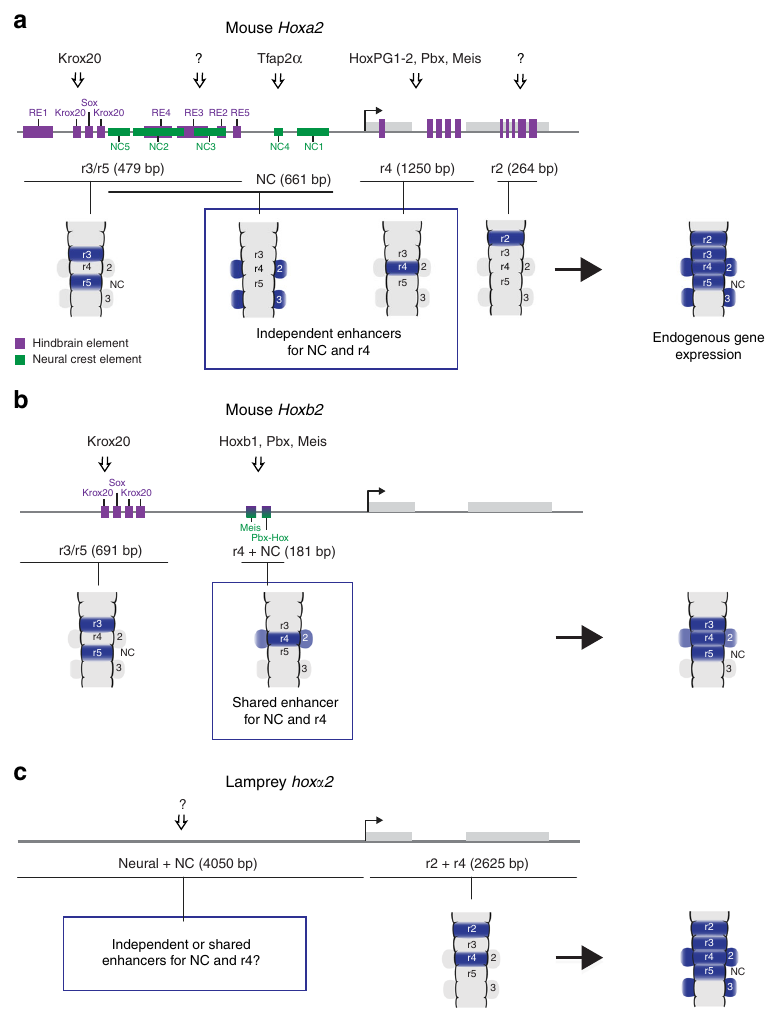
Fig. 1 Characterized Hox2 enhancers regulating neural crest (NC) and rhombomeric expression from mouse and lamprey. Schematic diagrams depicting the known enhancers regulating mouse Hoxa2 ( a ) and Hoxb2 ( b ), and lamprey hox α 2 ( c ), in rhombomeres (r) and NC. For each locus, the gene exons are represented by grey boxes and the transcriptional start site by an arrow. Enhancers are marked as black lines below the loci, with their activity domains illustrated by blue shading in schematic dorsal views of the hindbrain (r2 – 5) and pharyngeal arches (2 – 3). For the mouse loci, characterised cis -elements contributing to enhancer function are depicted as coloured boxes: hindbrain elements in purple and NC elements in green (not drawn to scale). Known direct inputs from transcription factors into these cis -elements are depicted by arrows, with unknown inputs shown as question marks. Hoxa2 is regulated in r4 and r4-derived NC (PA2) by independent enhancers ( a ). Hoxb2 expression in r4 and NC is mediated by a single enhancer, through cis -elements bound by Meis and Pbx-Hox factors ( b ). Since these elements have dual hindbrain/NC activity they are depicted in both purple and green. Genomic regions from the lamprey hox α 2 locus have enhancer activity, with an r2/r4 enhancer positioned within the exons and intron ( c ). The hox α 2-hox α 3 intergenic region drives reporter expression in the hindbrain and NC. However, it is not known whether this is through independent or shared NC/hindbrain enhancers, speci fi c cis -elements have not been identi fi ed, and the relationship of this region to the gnathostome Hoxa2 and Hoxb2 enhancers is